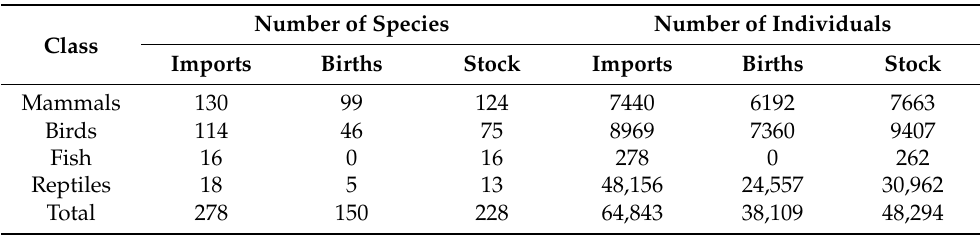
Table 1. Total number of imported living animal species and individuals (1996–2015), births, and